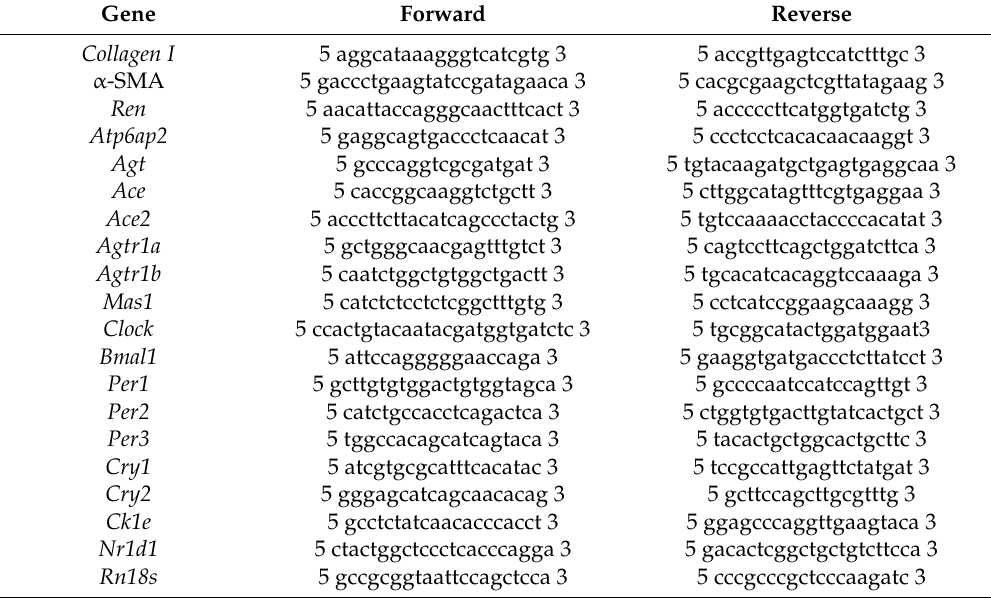
Table 1. Quantitative real-time polymerase chain reaction primers